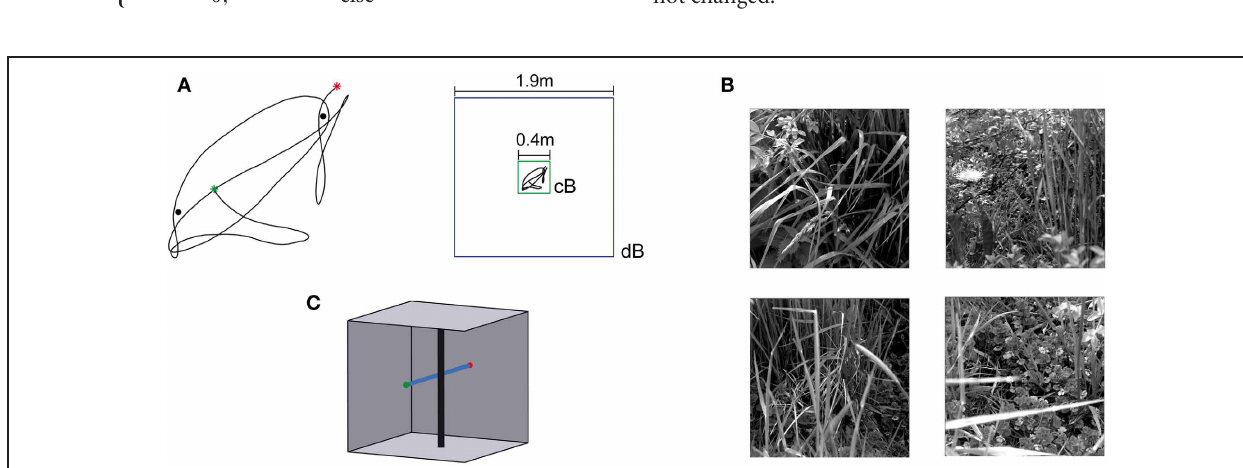
FIGURE 3 | Flight trajectory and stimulus conditions. (A) Left: Horizontal projection of the natural trajectory (black line) into the horizontal plane. The green dot tags the starting point, and the red dot, the end point of the trajectory. Two objects were placed near the trajectory for the environmental condition “with objects.” The black dots mark the locations of the objects. Right: a cube with an edge length of 0.4 m was used (green square) for the environmental condition with close background (cB), and for the distant background (dB) environment, the edge length was 1.9 m (blue square). The